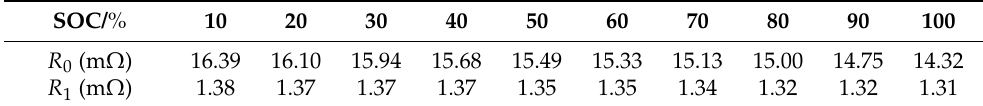
Table 2. Resistance R 0 and resistance R 1 at different SOCs.